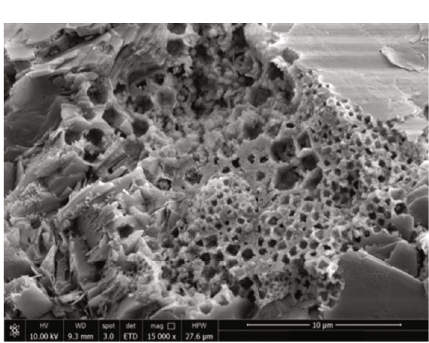
Figure 7: SEM result of A1